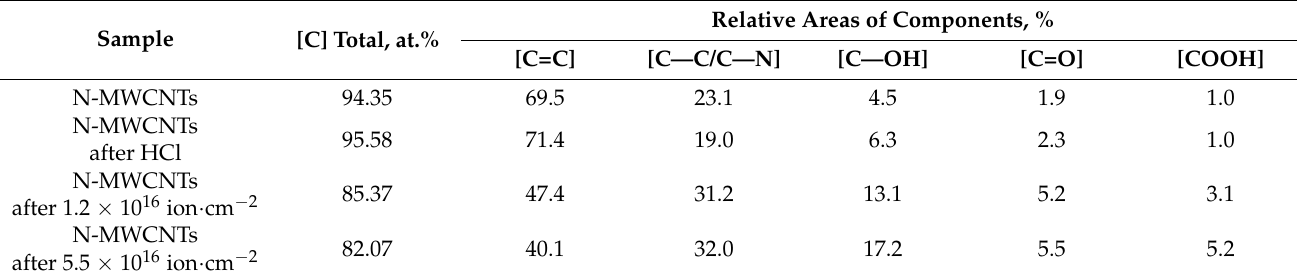
Table 2. Five-component approximation for C 1s PE